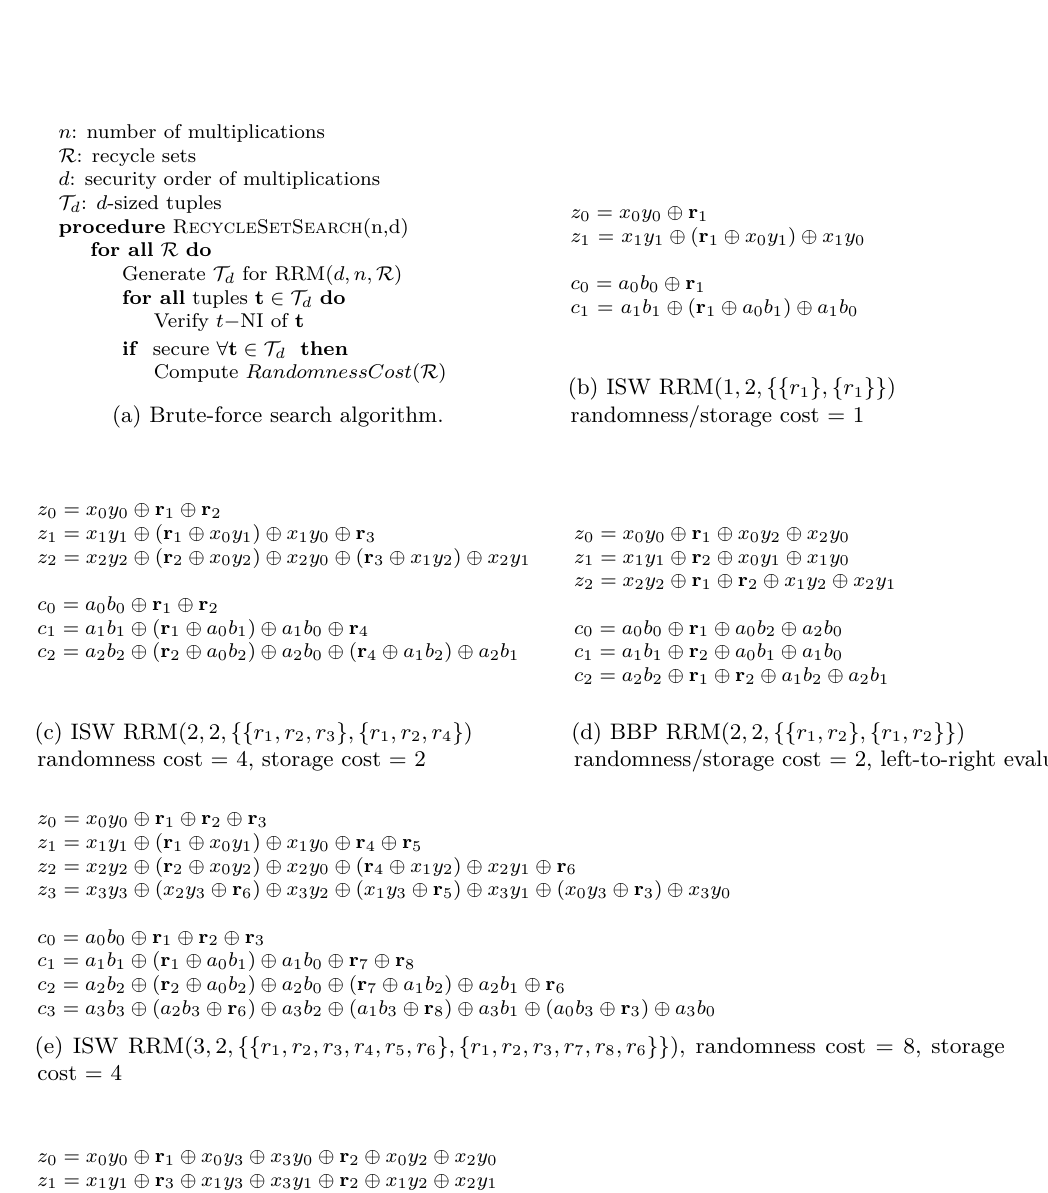
Figure 3: Efficient RRM